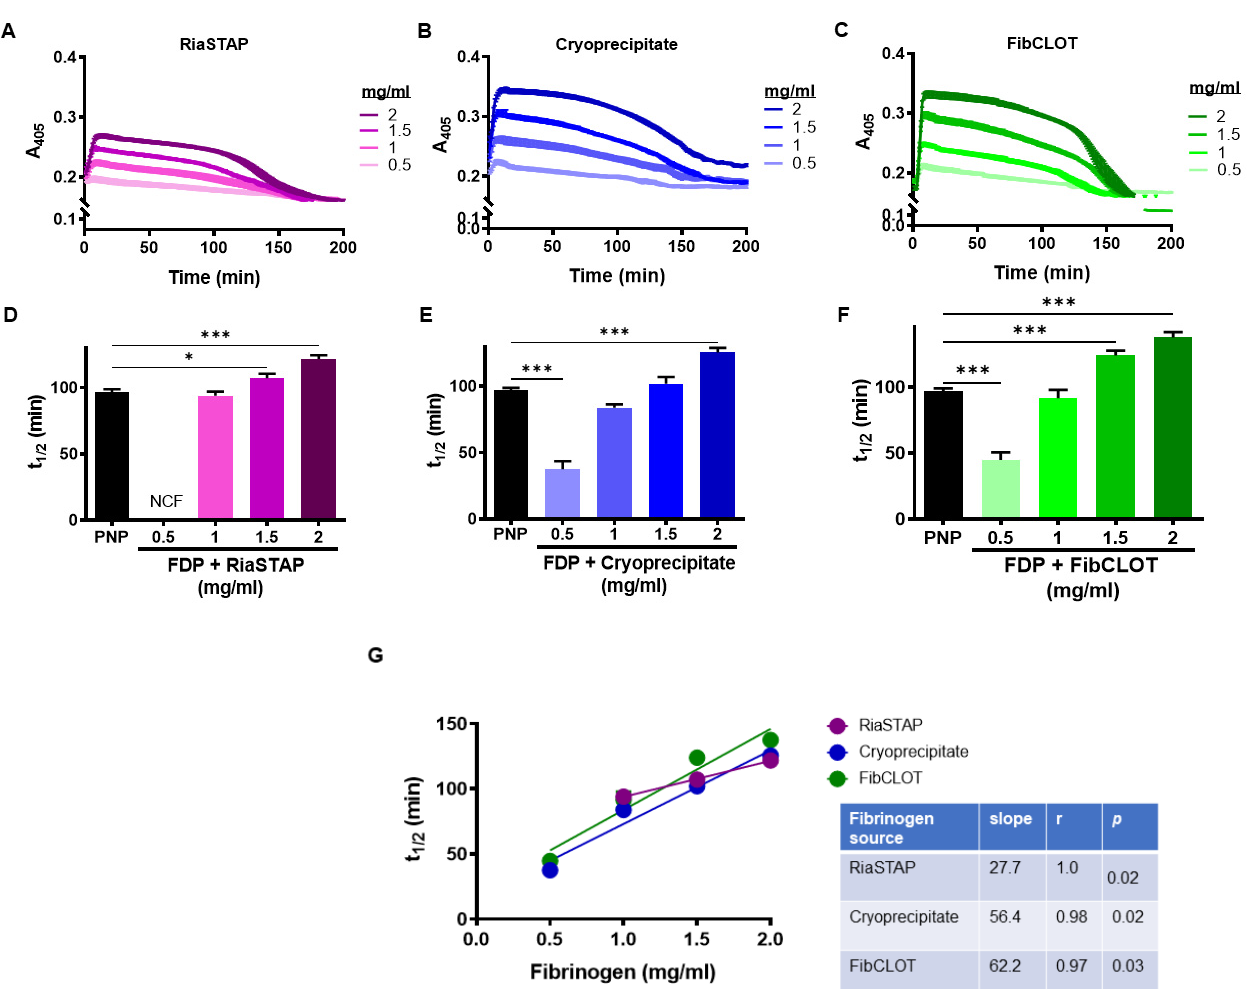
Figure 2. Addition of fibrinogen delays lysis. Clots contained 30% PNP or FDP, 16 µ M phospholipids, 300 pM tissue plasminogen activator (tPA) ± FibCLOT ® , RiaSTAP ® or cryoprecipitate at 0.5–2 mg/mL. Clotting was initiated with 0.1 U/mL thrombin and 10.6 mM CaCl 2 and the change in absorbance measured at 405 nm. ( A – C ) Raw lysis curves and ( D – F ) 50% lysis time show a clear increase in resistance to lysis with increasing fibrinogen concentration of RiaSTAP ® , cryoprecipitate and FibCLOT ® , respectively. ( G ) Correlation of 50% clot lysis times with fibrinogen concentration. Data shown are mean ± SEM, n = 4, * p < 0.05 and *** p < 0.001 compared with PNP.